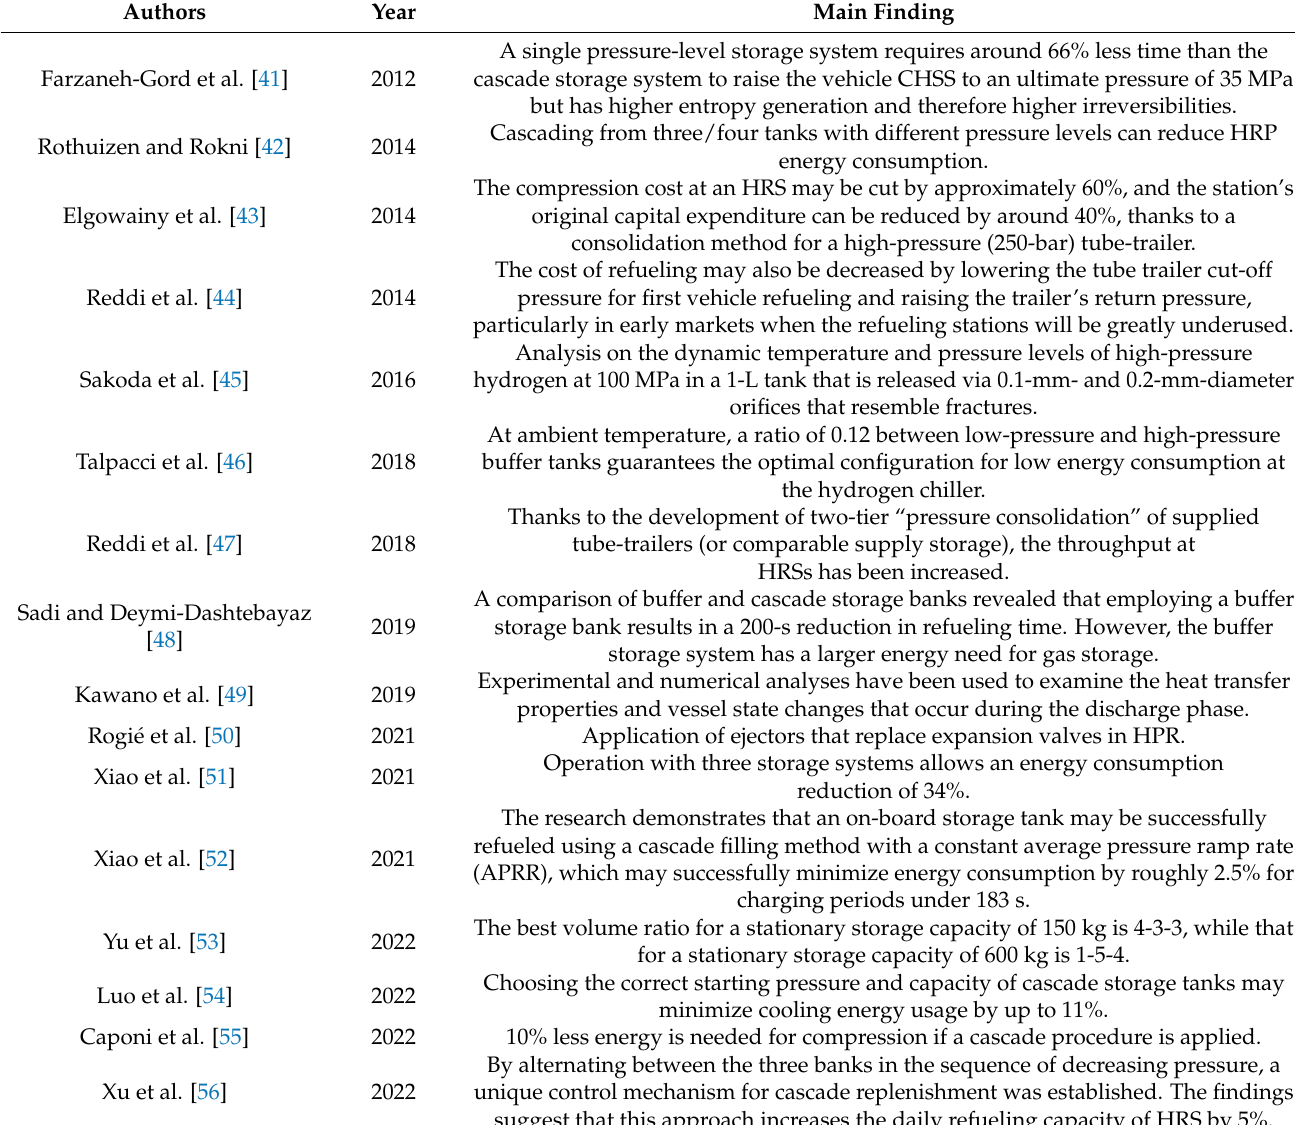
Table 2. Main research activities on cascade hydrogen